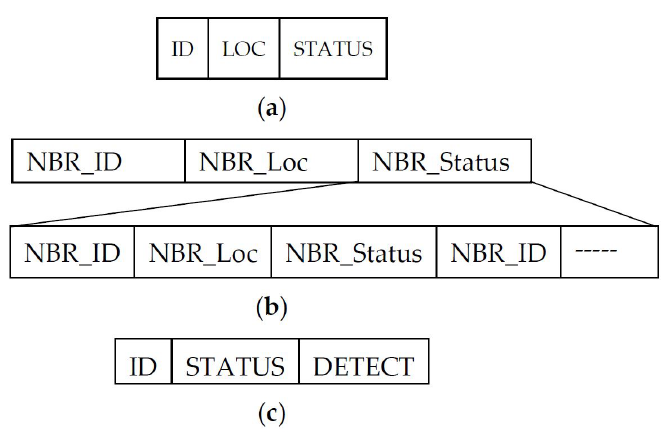
Figure 7. ( a ) BOOTUP message format. ( b ) Neighbor-table maintained by each node. ( c ) Detection status exchange message format. DETECT field is used to detect the node